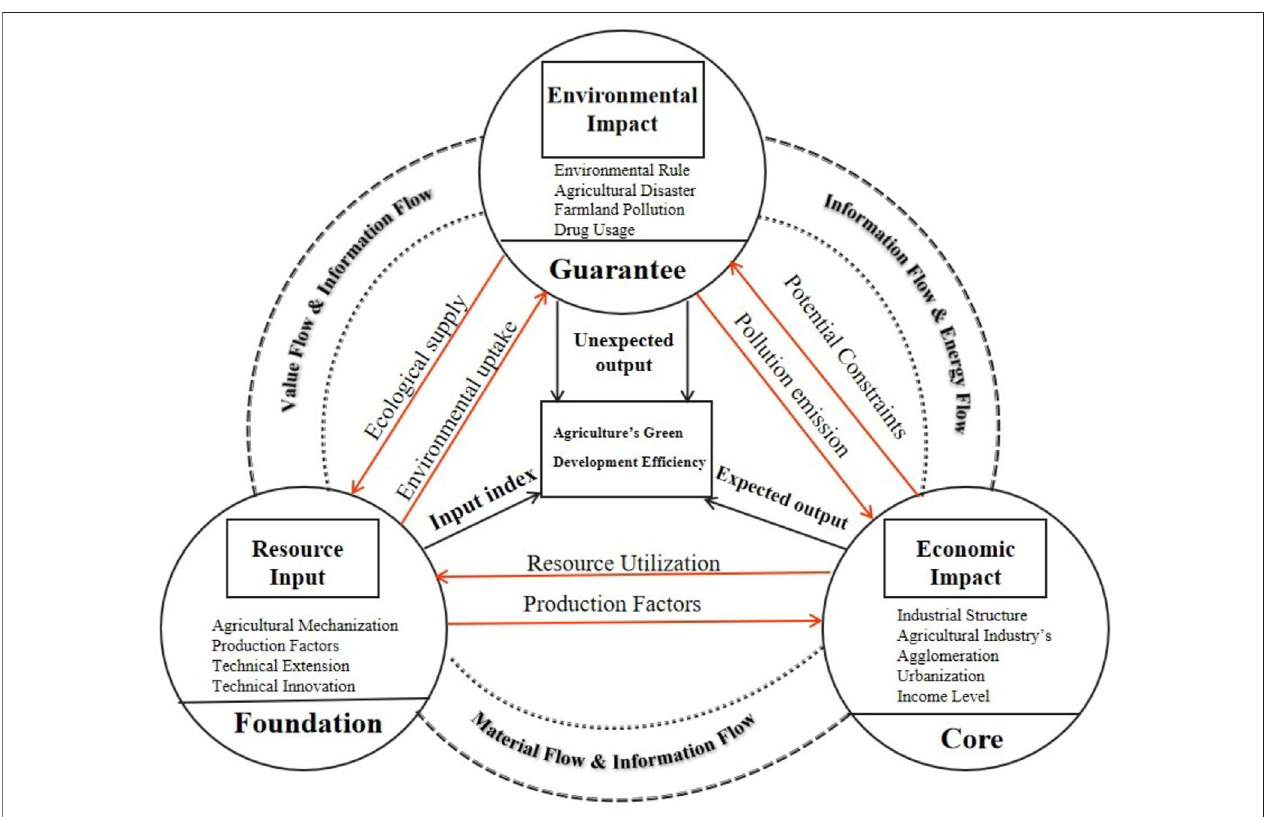
FIGURE 1 | Theoretical model of factors in fl uencing green agriculture